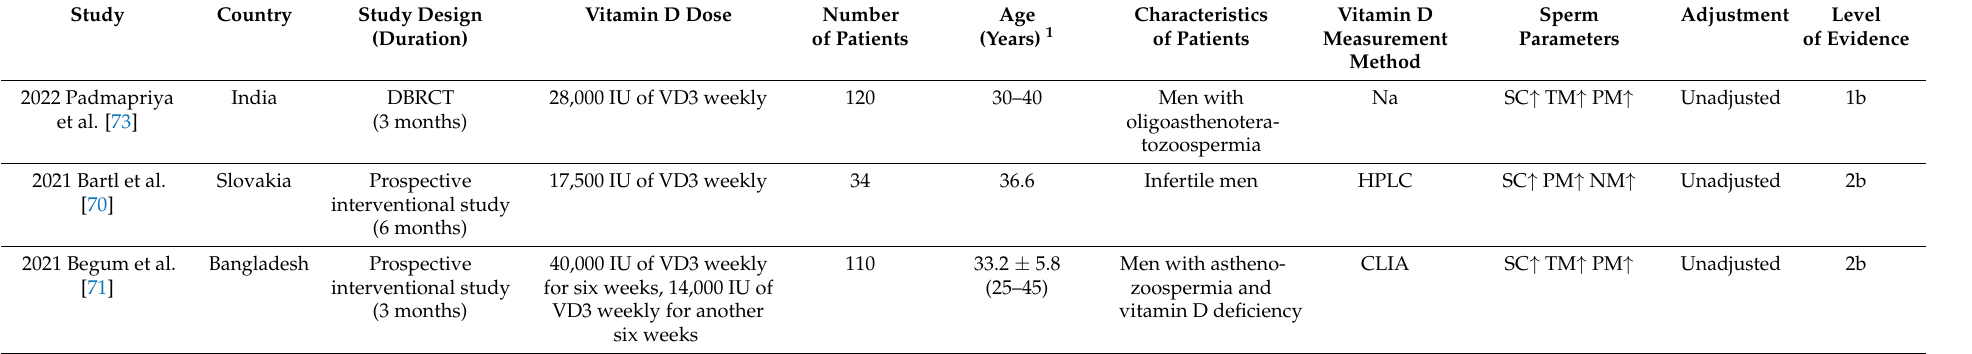
Table 2. Summary of Interventional Studies between Vitamin D and Semen Quality Parameters in